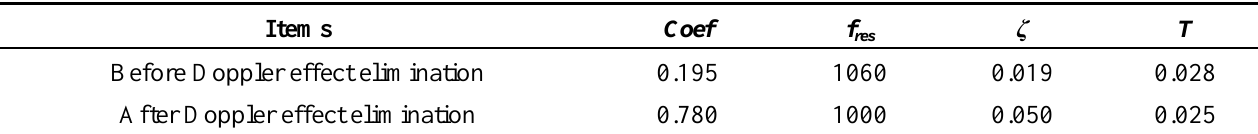
Table 2. Comparison of the transmit model analysis results between the signals before and after Doppler effect